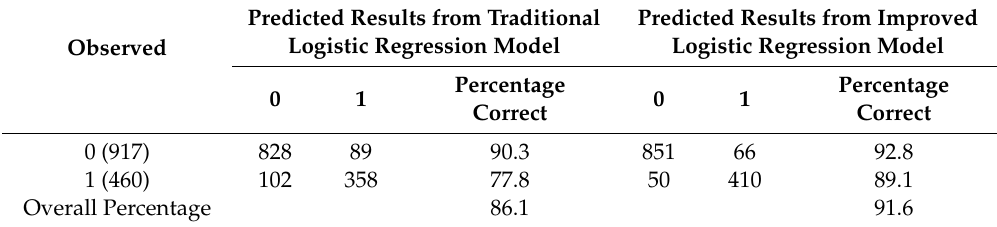
Table 6. The fitting accuracy of the traditional model and the improved model calculated by multivariable logistic regression